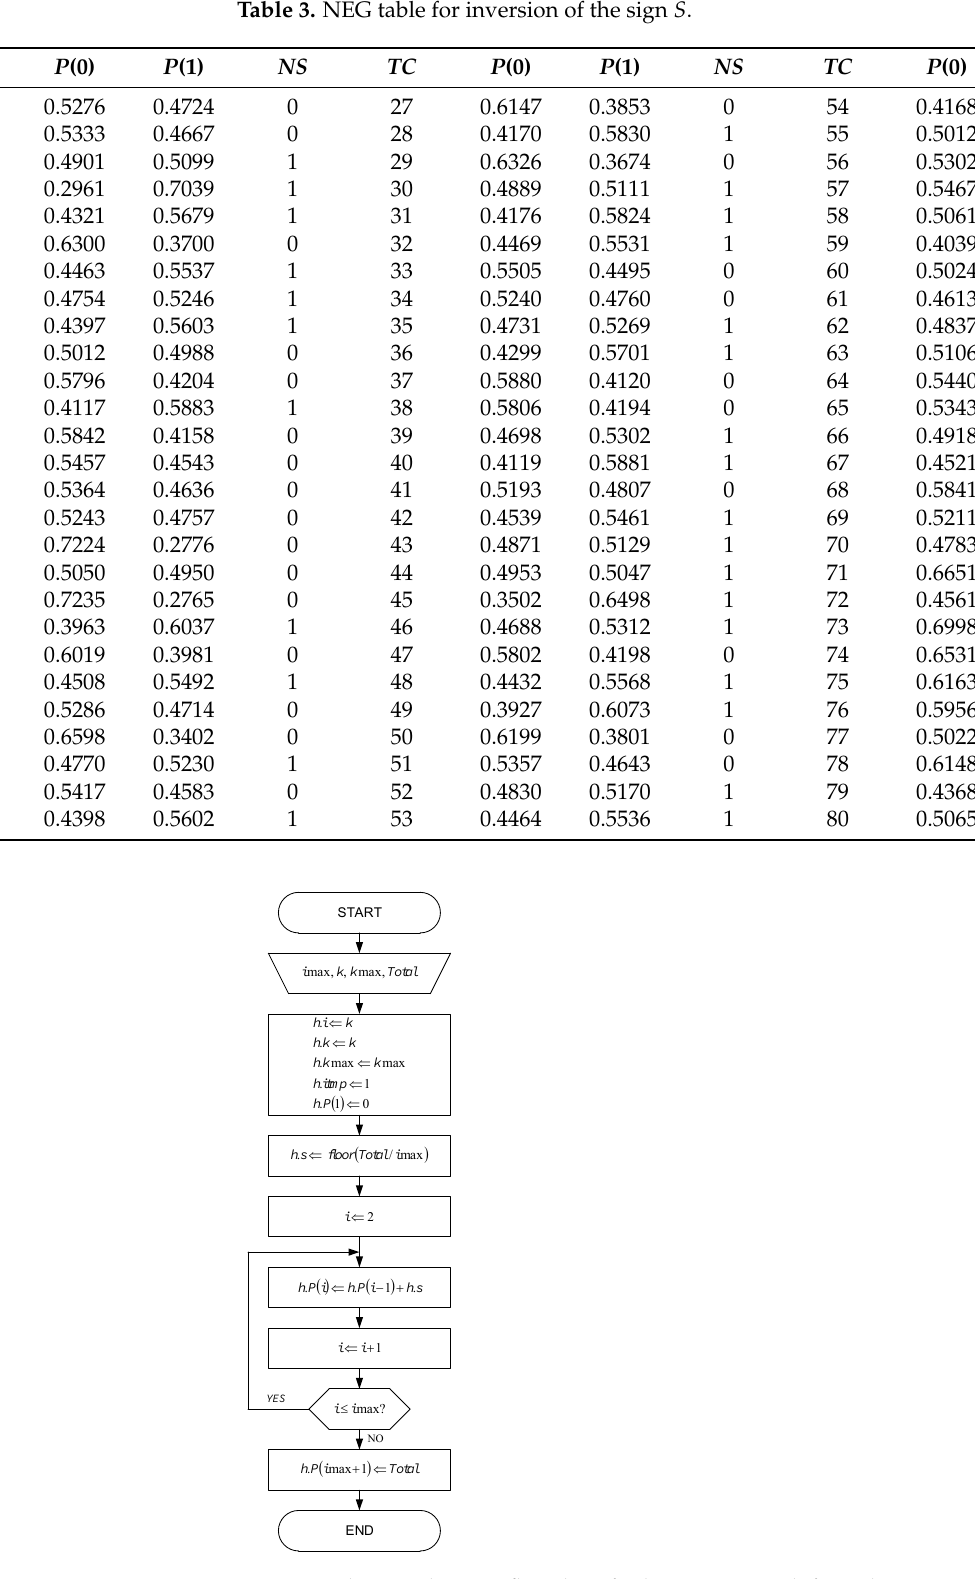
Figure 4. The initialization flowchart for histograms with fast adaptation.